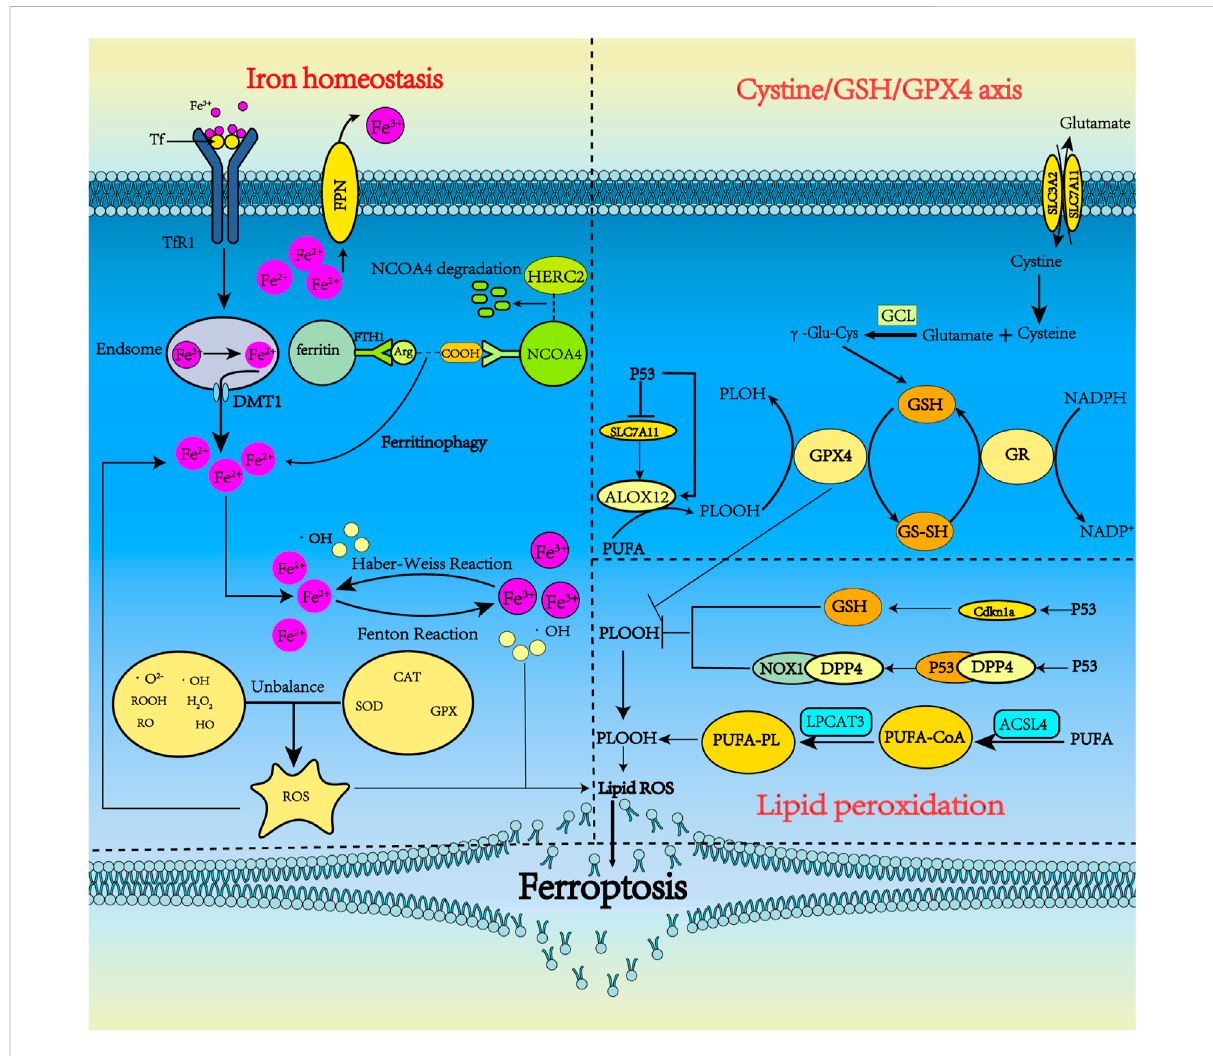
The metabolism pathways for ferroptosis. Ferroptosis can occur through three major pathways, iron homeostasis, the cystine/GSH/GPX4 axis, and lipid peroxidation. 1) Iron homeostasis. Tf carrying Fe 3+ forms a complex with TfR1 and enters neurons via clathrin-mediated endocytosis. Fe 3+ detaches from Tf and then is reduced by STEAP3. Fe 2+ is pumped into the cytoplasm by DMT1 and is stored in ferritin in the form of Fe 3+ when overloaded. Under some conditions, ferritin undergoes autophagy by binding with NCOA4, releasing iron, which subsequently leads to lethal iron levels and ferroptosis. NCOA4 can interact with HERC2, leading to NCOA4 degradation. Ferritinophagy increases LIP, which can activate the FentonandHaber-WeissreactionstogenerateROS.2)Cystine/GSH/GPX4axis.Systemxc − includestwochains:aspeci fi clightchain,SLC7A11,anda heavychain,SLC3A2.Throughsystemxc − ,Gluandcystineenterandleavethecellinequalamounts.Cystine,whichisingested,isthenreducedto γ - Glu-CysinthecellandbecomesinvolvedinthesynthesisofGSH.GSHiscontinuouslyproducedbyGCLandGSS.Inferroptosis,GPX4usesGSHasa substrate to mediate the lipid-OOH conversion to lipid-OH, and the sulfhydryl group in GSH reduction is readily dehydrogenated to form oxidized glutathione disul fi de (GSSG), which plays an antioxidant role. P53 could indirectly trigger arachidonate 12-lipoxygenase (ALOX12) function through transcriptionalinhibition ofSLC7A11,thus leading to ALOX12-dependentferroptosis resulting fromROS stress. 3) Lipid peroxidation.PUFA produces a large amount of lipid ROS through the continuous action of ACSl4 and LPCAT3. p53 can inhibit ferroptosis by inhibiting DPP4 activity or inducing CDKN1A